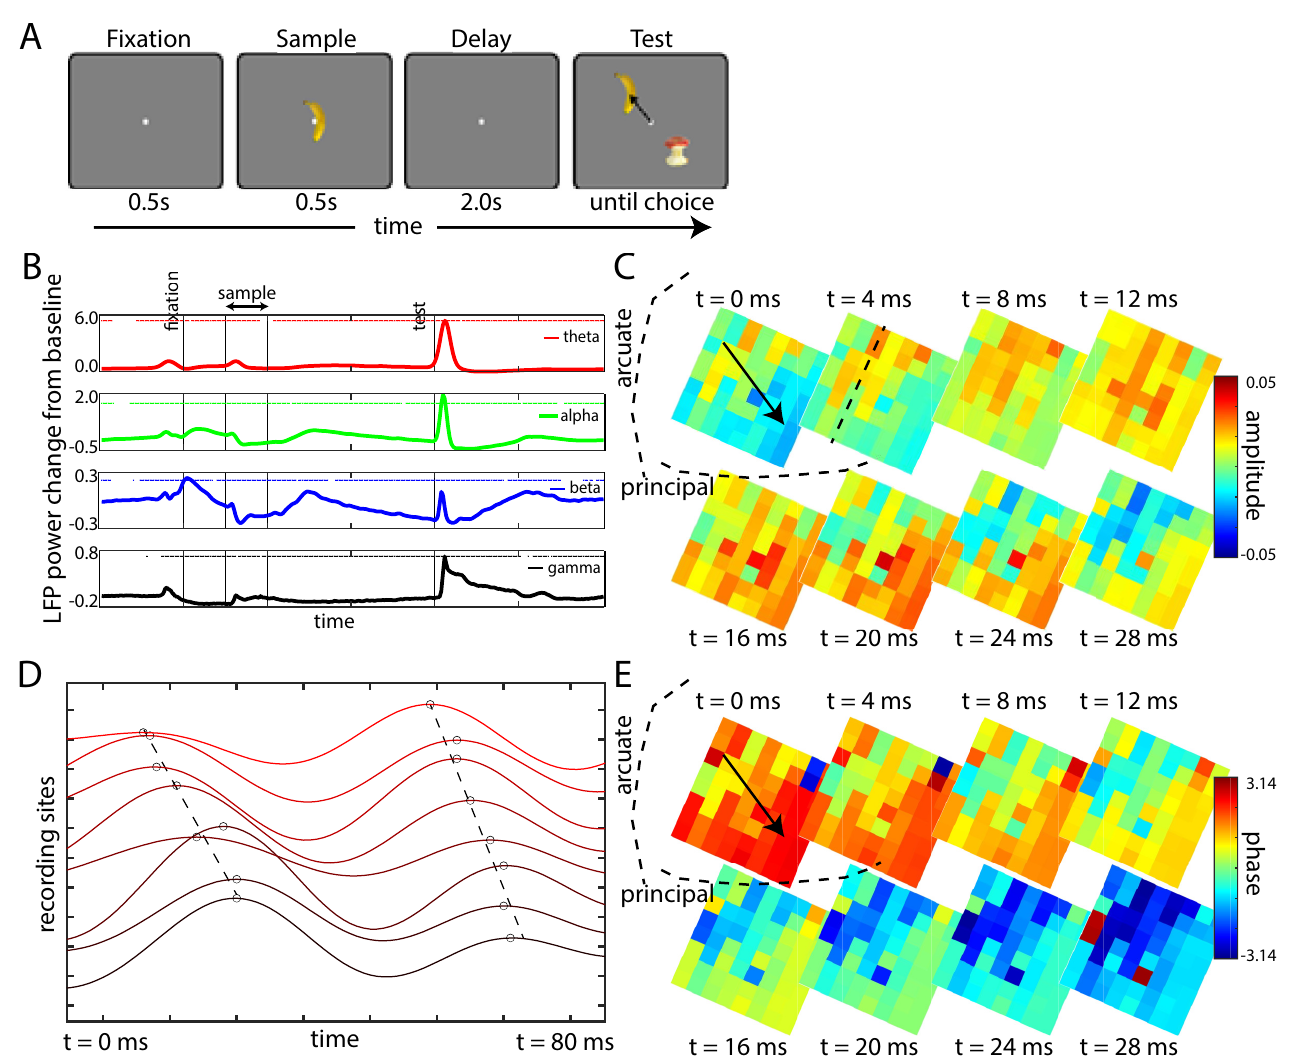
Fig 1. (A) Delayed-match-to-sample (DMTS) working memory task. The subject fixated at the center for 0.5 s (leftmost panel) before an object (one of eight) were presented at the center for another 0.5 s. There was a 2 s blank memory delay after which a test screen was presented at extrafoveal locations. The subject had to saccade towards the remembered object and hold fixation there (arrow, rightmost panel). (B) Filtered LFP power trends for all electrodes (four arrays), trial- averaged and shown across time with the lines denoting the major trial epochs. Four frequency ranges were chosen–theta (4–8 Hz), alpha (8–12 Hz), beta (12–30 Hz) and gamma (40–120 Hz), with the dots above the curve denoting if the LFP power at that instant is significantly (p < 0.01) different from baseline (0.5 before fixation started). (C) Theta LFP organization across the right hemisphere array of Subject 1 of a particular trial. Each tile denotes a recording site on the array (8x8 total) with the color denoting the LFP amplitude at that site. The array position with respect to anatomical brain landmarks is overlaid. Each panel denotes the organization at an instant in time. The black arrow in the second panel indicates the direction of movement of the high amplitude LFPs with time. (D) Voltage traces from the 8 adjacent electrodes (color graded by position) in a row of the array in (C–dashed line). The circles mark the peak positions of the oscillation cycles with the dashed line indicating how the peaks shift gradually in time and space. (E) Phase maps from the corresponding panels in (C) with the color on each tile denoting the phase of the LFP oscillation cycle on that recording